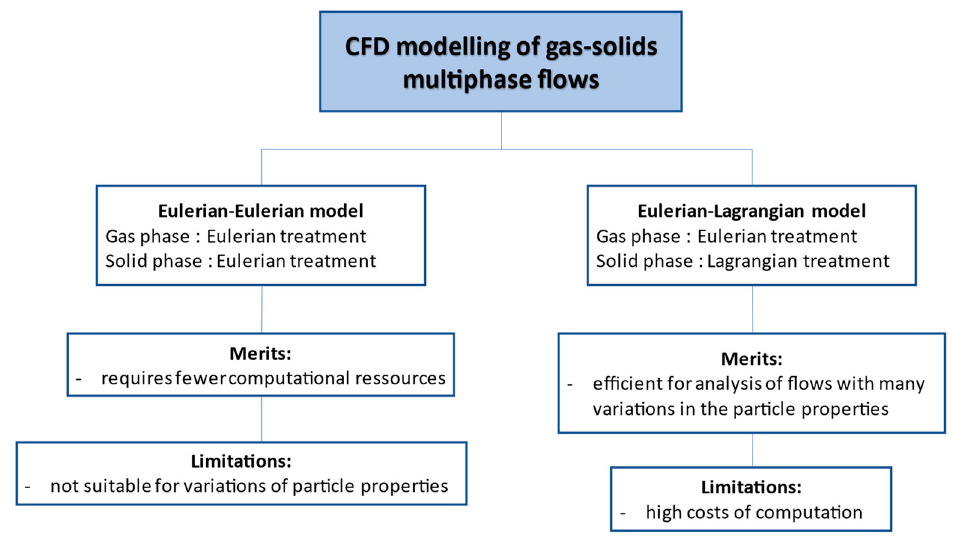
Figure 10. Particle-laden flow regimes, adapted from [35].